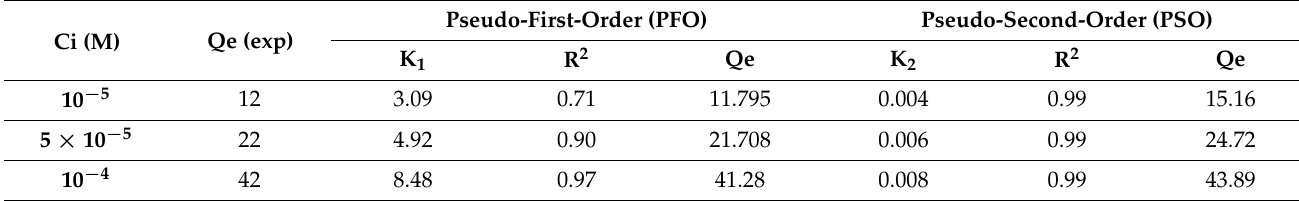
Figure 6. Adsorption kinetics of MG using AP from aqueous solution. Table 2. Kinetic parameters for the MG adsorption on AP at different concentrations.